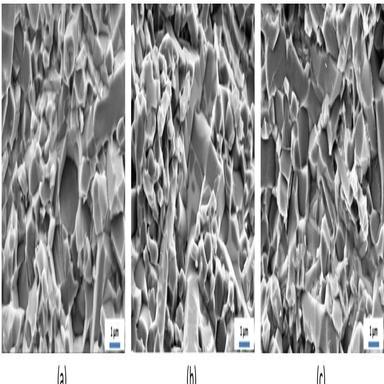
SEM images showing the fracture surfaces of bend bars tested in 4PB cyclic fatigue (a) in air at RT, (b) in air at 1000 °C and (c) in water at RT.